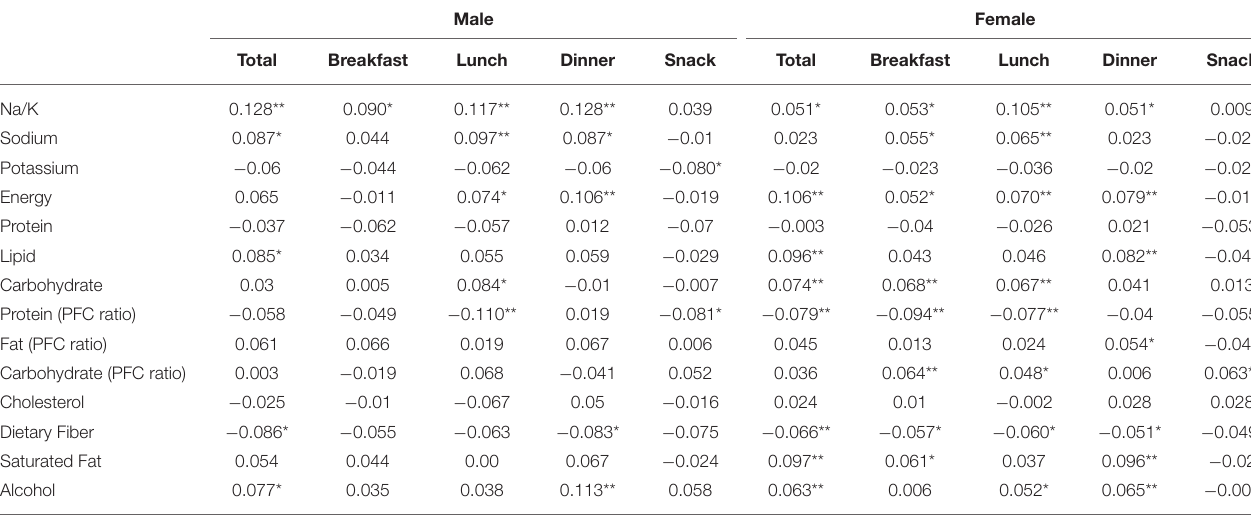
TABLE 2 | Correlations analyses of intake of nutrients and blood pressure. Male Female Total Breakfast Lunch Dinner Snack Total Breakfast Lunch Dinner Snack